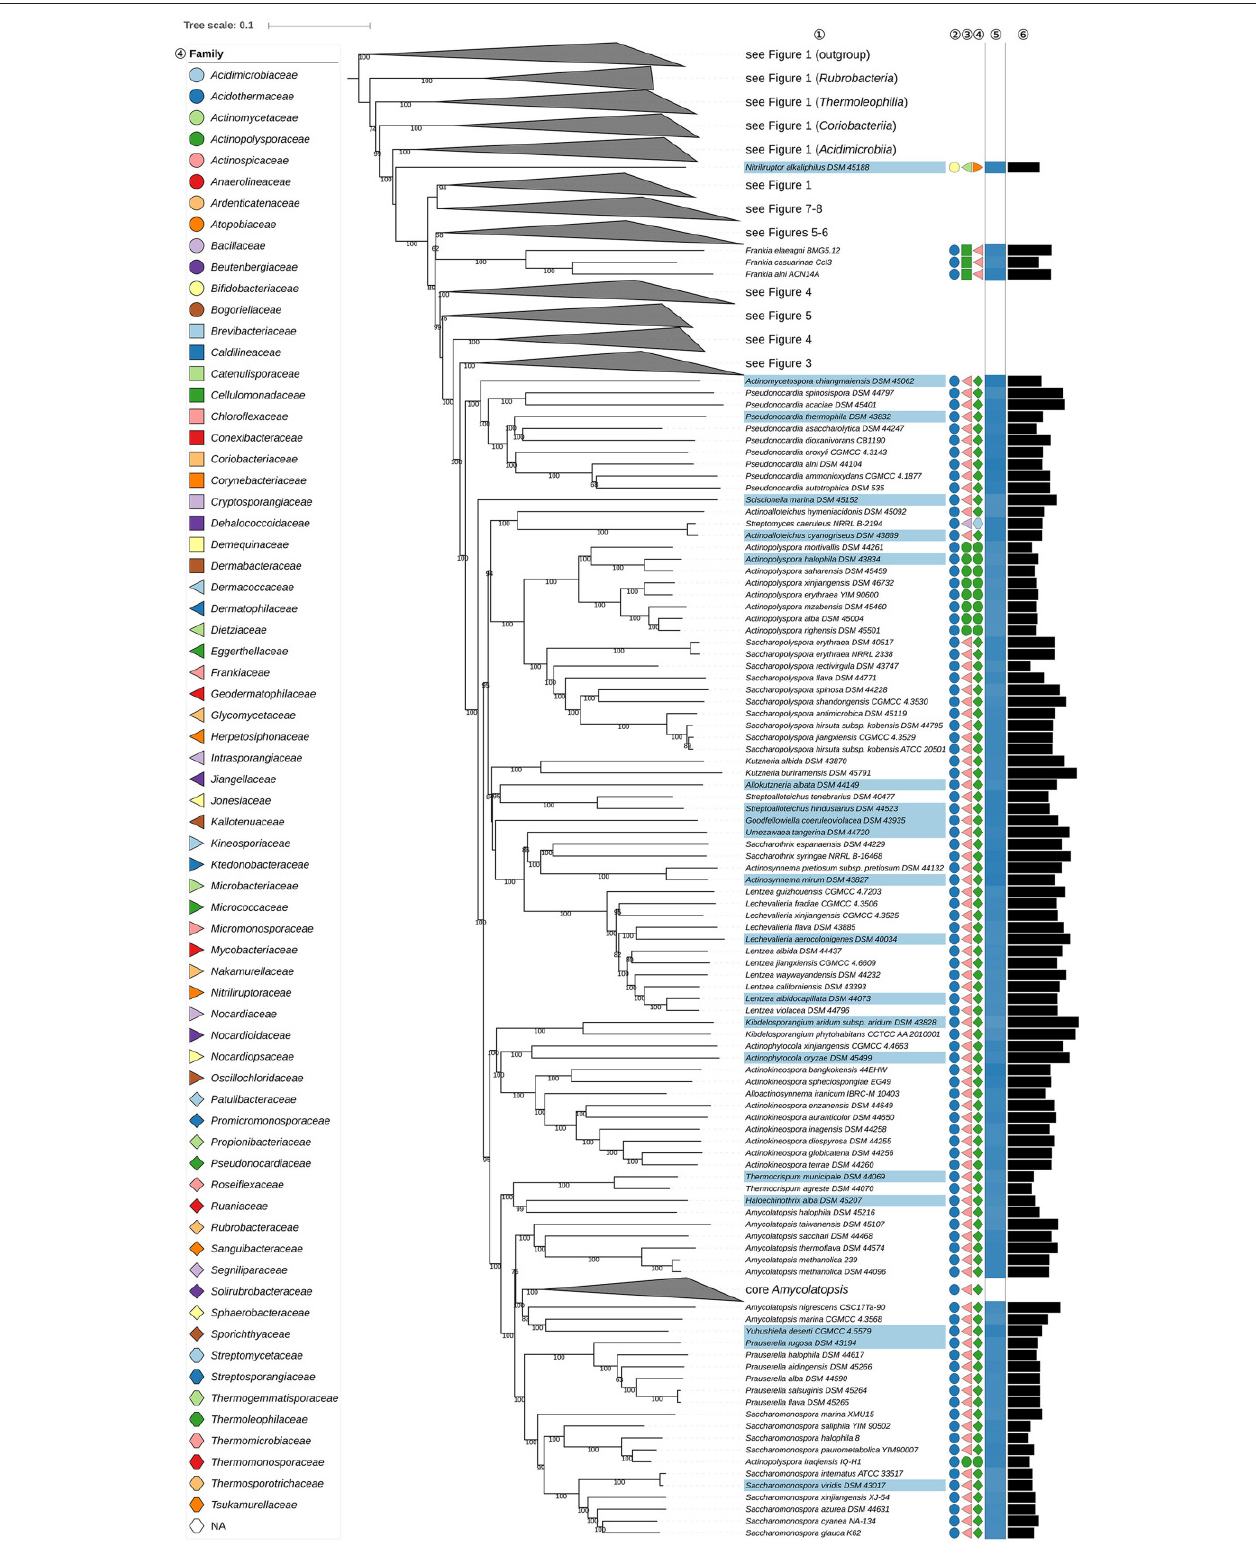
FIGURE 2 | Second part of the phylogenomic tree inferred with GBDP. A detailed description is provided in the caption of Figure 1 . The parts of the tree which have been collapsed here are shown in other figures as indicated.